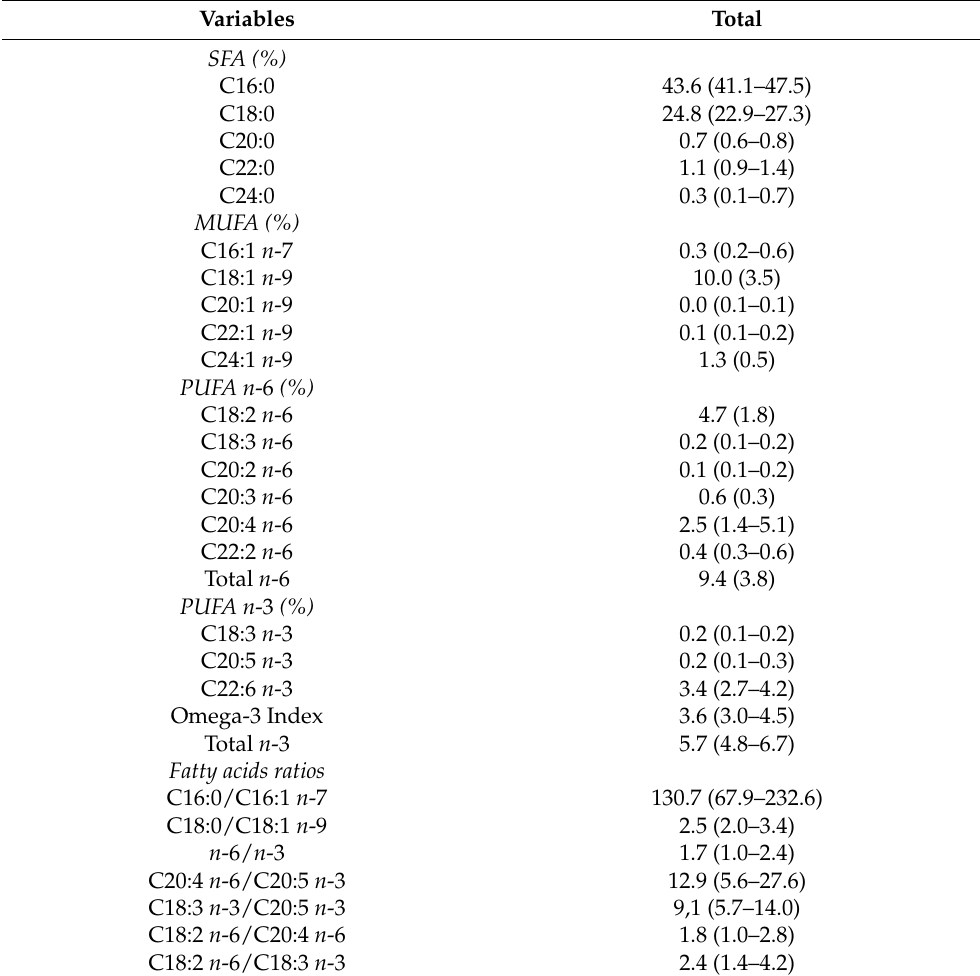
Table 3. Erythrocyte membranes fatty acids profile ( n =